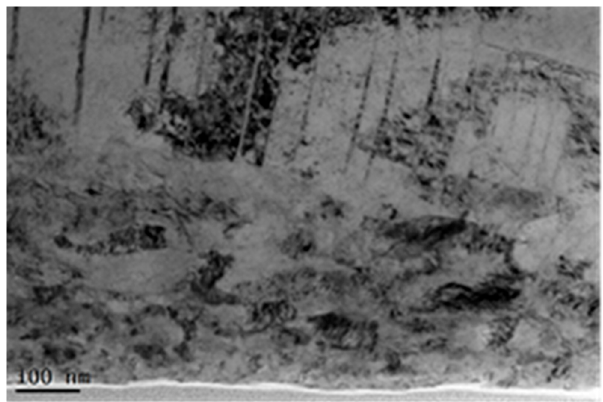
Figure 6. The cross ‐ sectional TEM image of the laser treated GH3039 superalloy. Figure 6. The cross-sectional TEM image of the laser treated GH3039